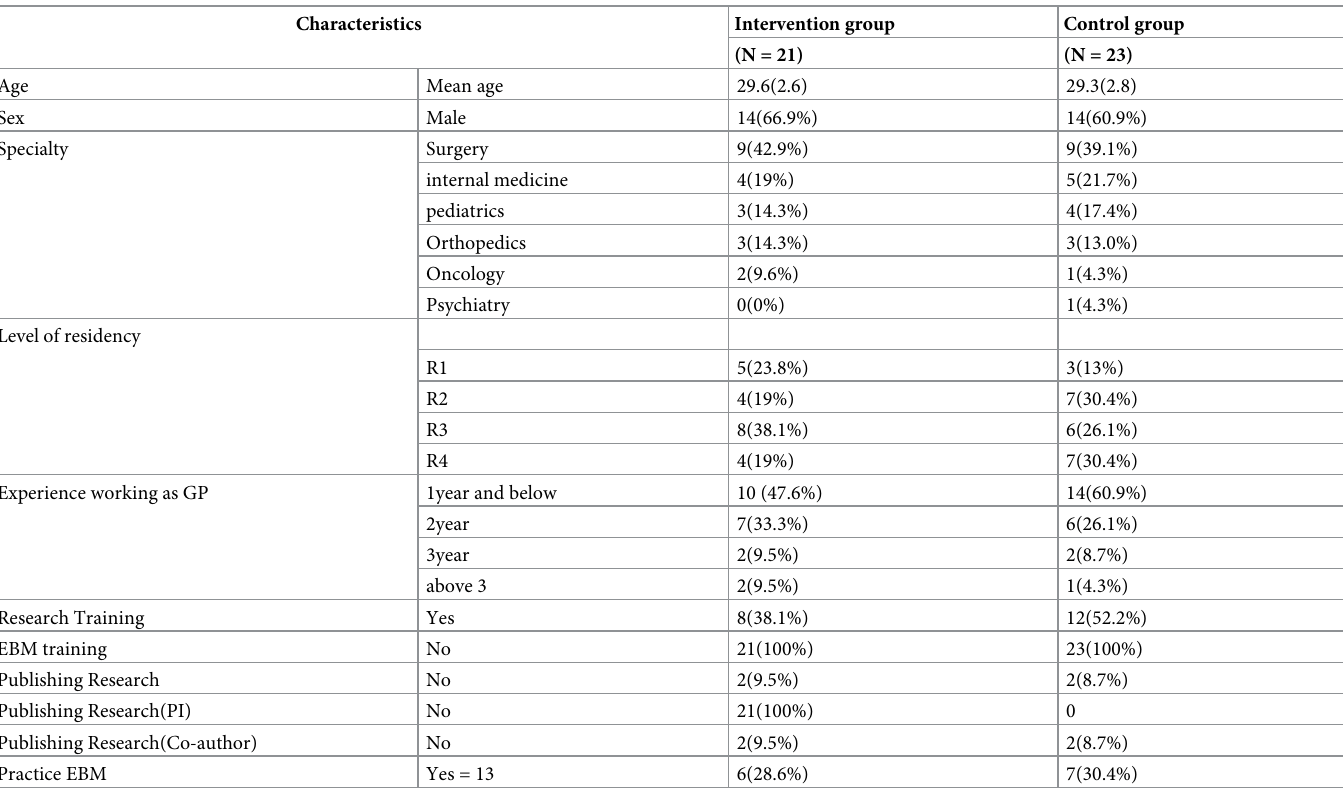
Table 1. Baseline characteristics of the study post graduate specialty in Ethiopia 2022.